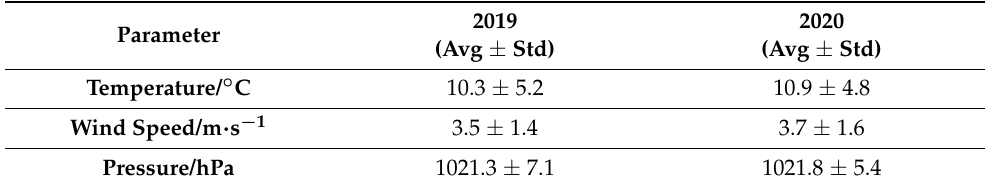
Table 2. Changes in meteorological parameters over Shanghai.